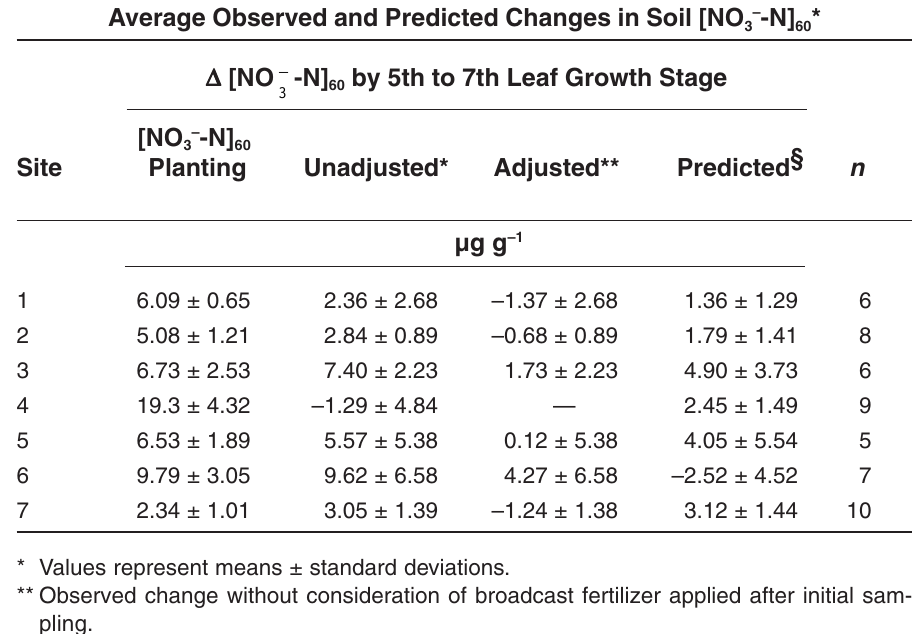
Average Observed and Predicted Changes in Soil [NO 3– -N]